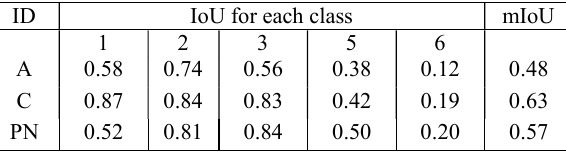
Table 10. Classification results of the test dataset for different combinations of